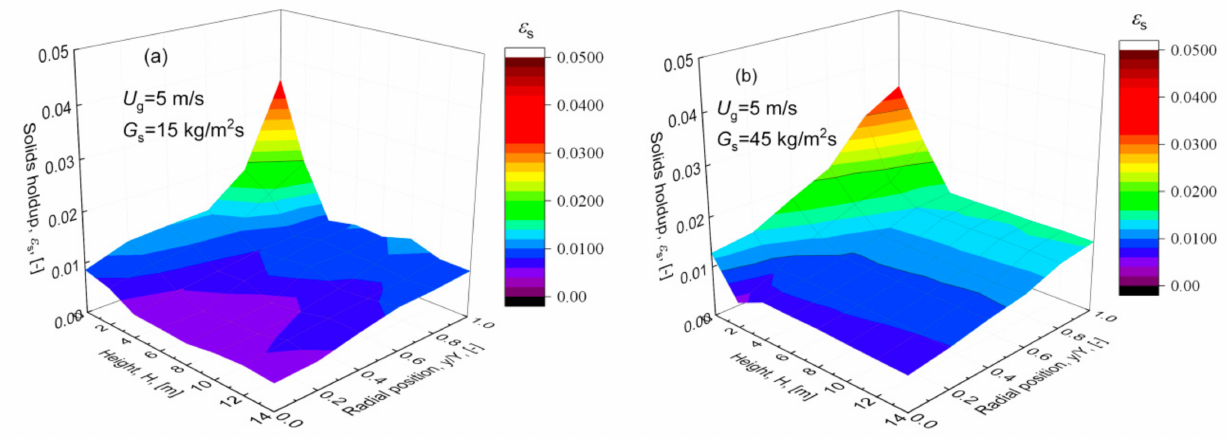
Figure 7. Three-dimensional diagram of the solids holdup with superficial gas velocity of 5 m/s. (( a ) represents the axial and radial distribution of solid holdup of particles when U g = 5 m/s, G s = 15 kg/m 2 · s, ( b ) represents the axial and radial distribution of solid holdup of particles when U g = 5 m/s, G s = 45 kg/m 2 · s). Axially, the solids holdup of desulphurization ash particles is denser in the riser bottom, and gradually decreases along the riser. Radially, the solids holdup near the